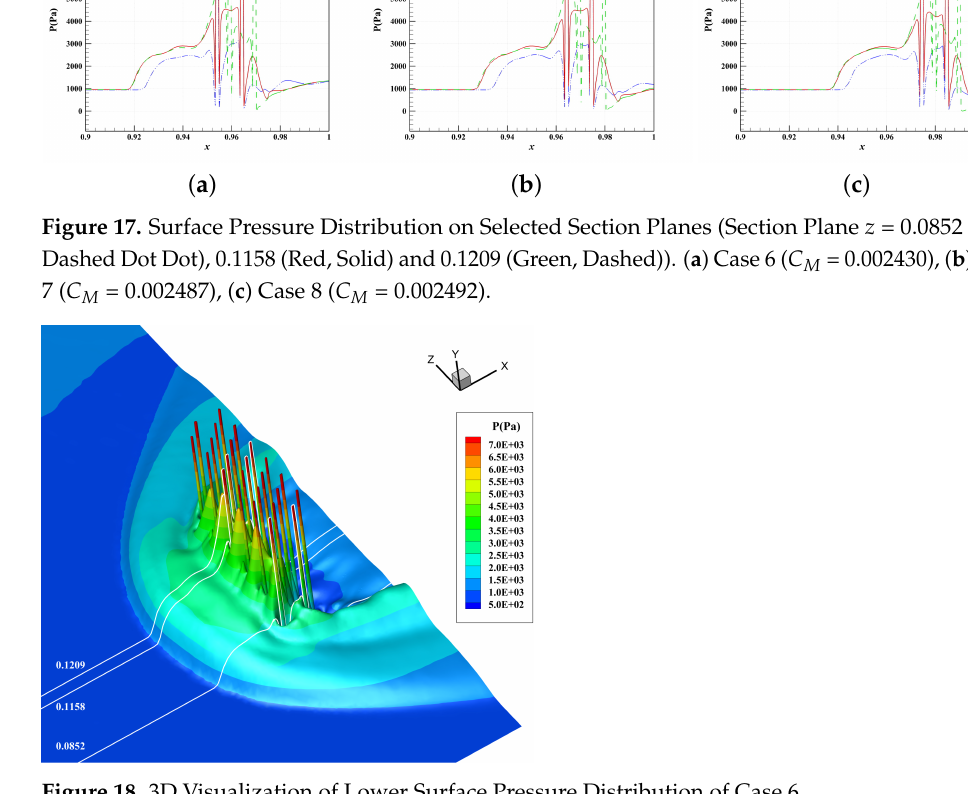
Figure 18. 3D Visualization of Lower Surface Pressure Distribution of Case